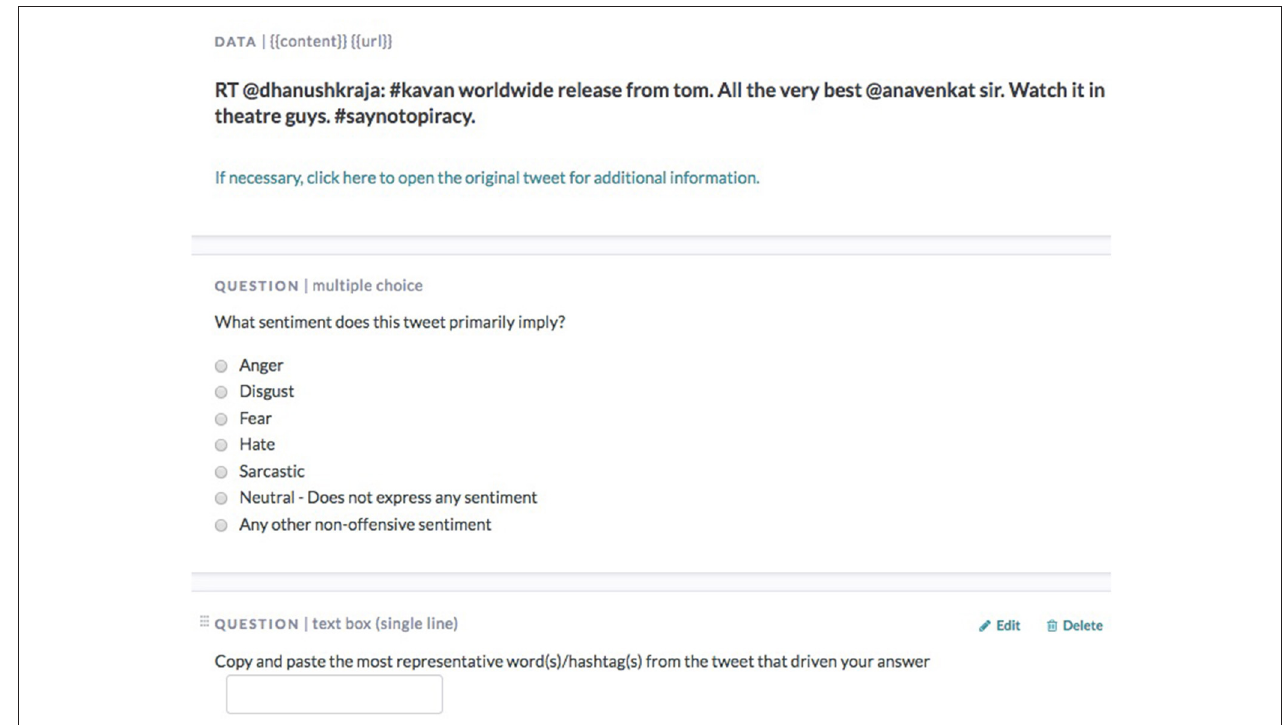
FIGURE 1 | A snapshot of the crowd-tagging process that took place through Figure-eight .